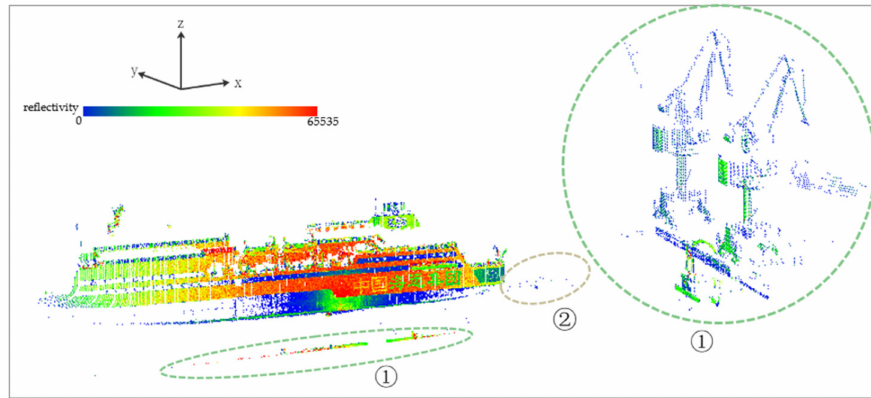
Figure 10. Two types of noise data.